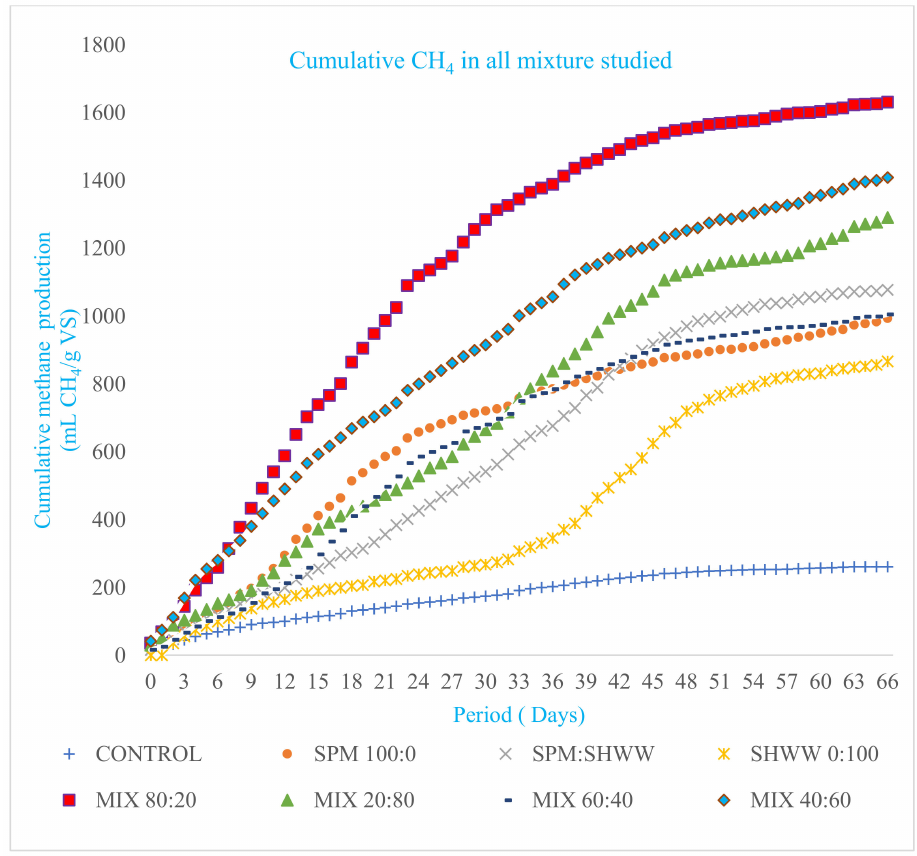
Figure 1. Cumulative methane yield in the investigated mix